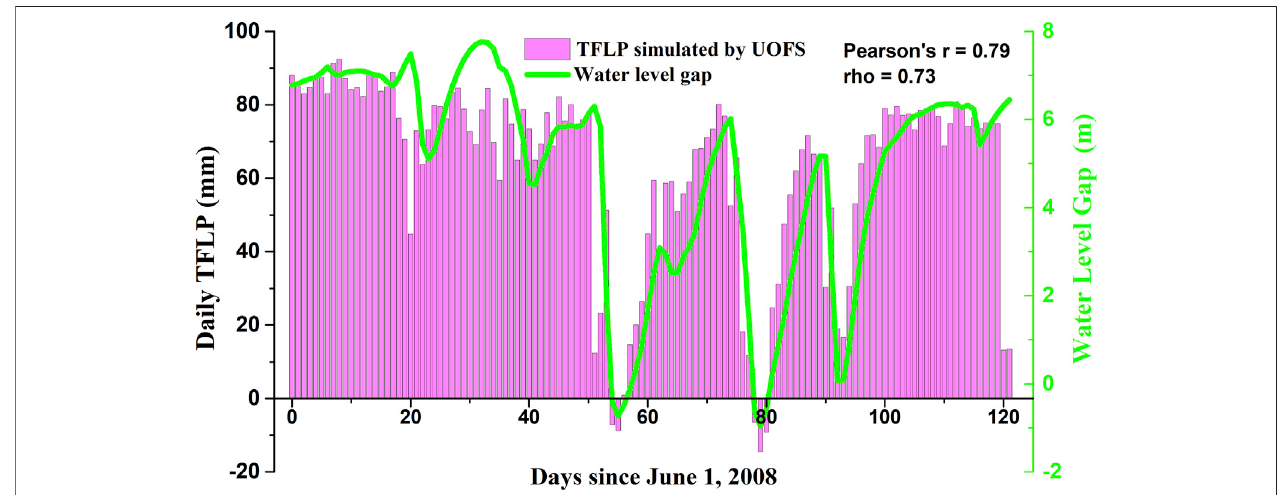
FIGURE 5 | Simulated daily TFLP and monitored water level gap in the WJB sub-basin during June to September 2008.